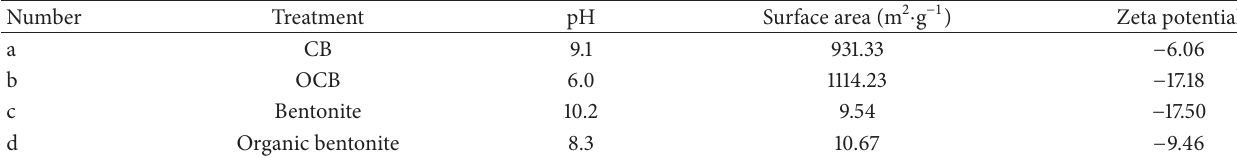
Table 4: Characteristics of different